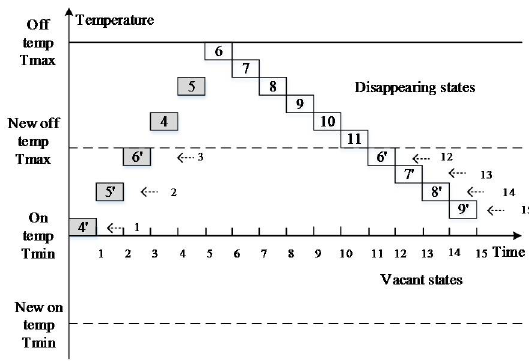
Figure 3. Load state transition diagram.